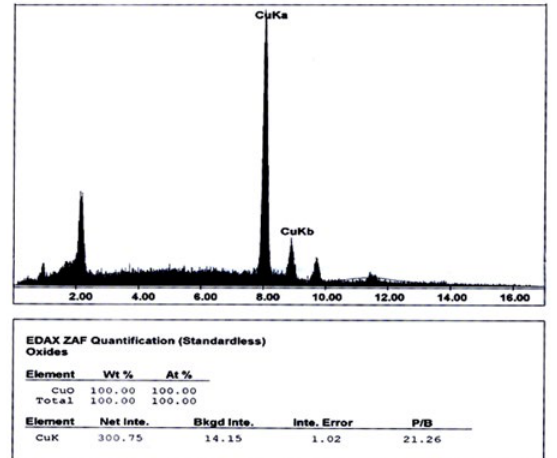
Fig. 5. EDX spectrum of the as-synthesized product by calcination of [Cu